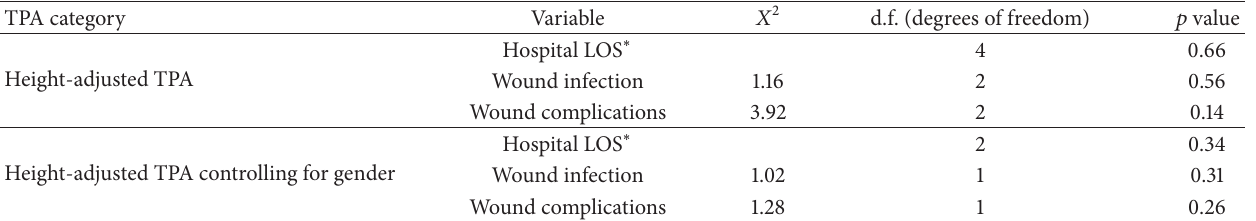
Table 4: Linear analysis of height-adjusted total psoas area (TPA) and hospital LOS, postoperative infection, and wound complications. TPA